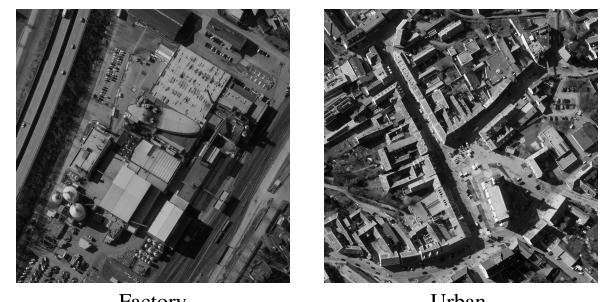
Figure 7: Image I r from subsets of a stereo pairs. Each subset is 2500 × 2500 pixels with a GSD of